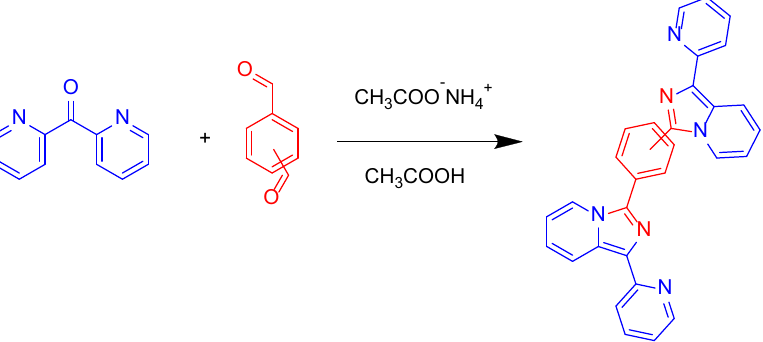
Scheme 1. General reaction scheme of one-pot microwave-assisted cycloaddition used for 1 – 3 . Benzaldehyde, terephthaaldehyde and isophthalaldehyde were employed for 1 – 3 ,